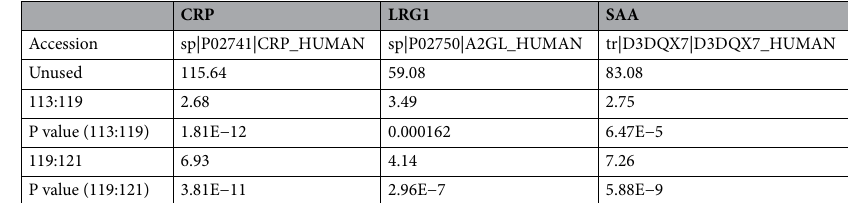
Table 4. iTRAQ information of identified